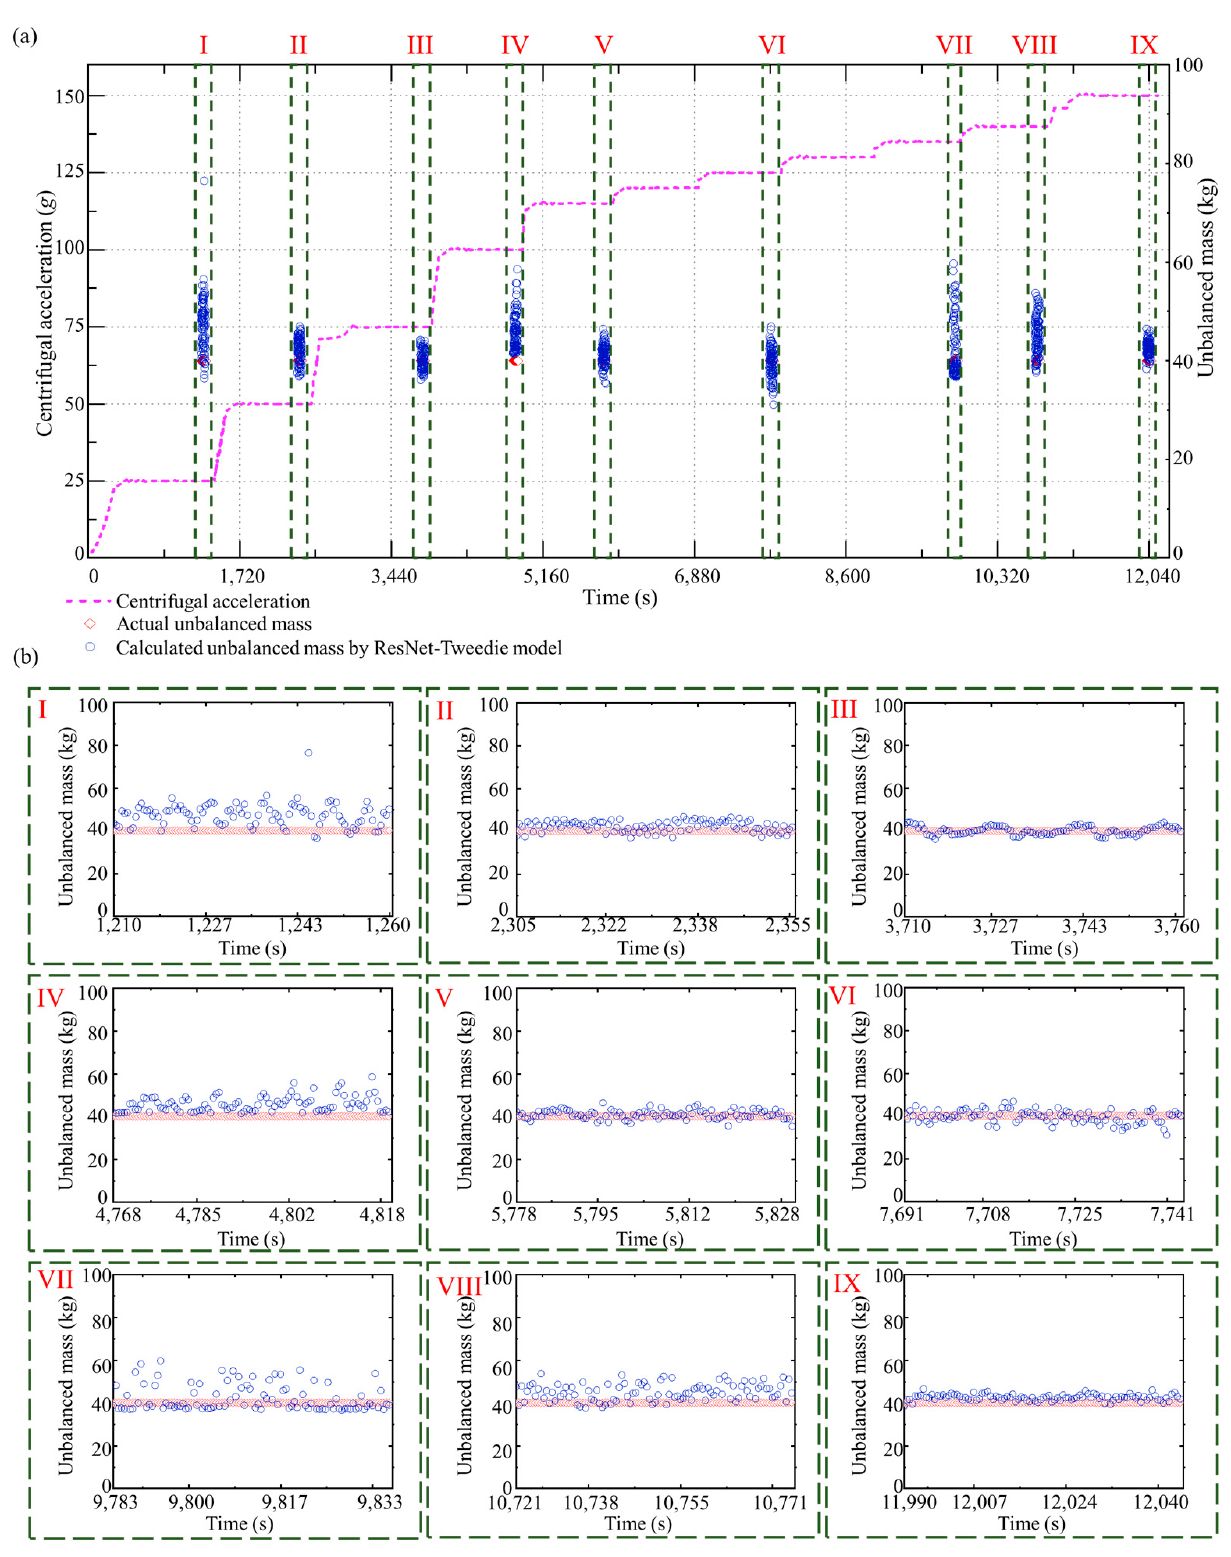
Figure 11. Unbalanced mass calculation results with the ResNet-Tweedie model. ( a ) The whole speed-up process. ( b ) Identi fi cation results during each centrifugal acceleration step.